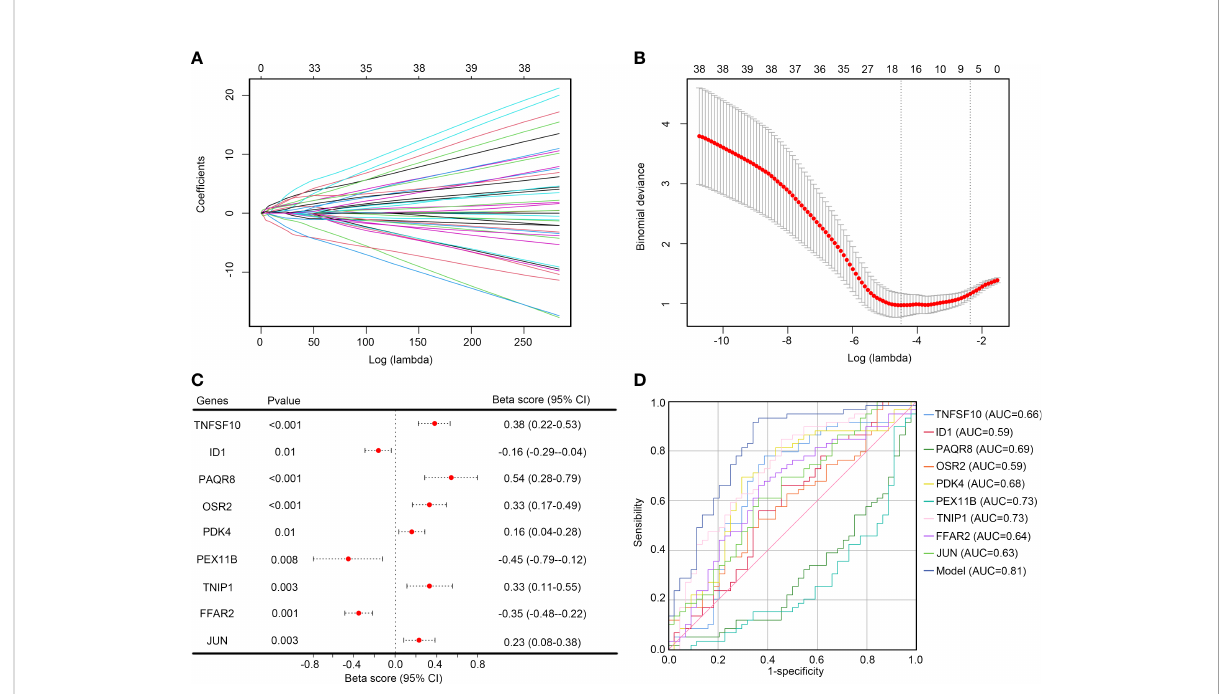
FIGURE 5 Selecting the optimal key in fl ammation-related genes to construct the fi nal diagnostic model (A) Screening of the optimal parameters and the vertical lines were drawn; (B) LASSO coef fi cient pro fi les of the 17 key in fl ammation-related genes; (C) Multivariate logistic regression determined independent candidate diagnostic biomarkers; (D) ROC analysis showing that this diagnostic model had good diagnostic